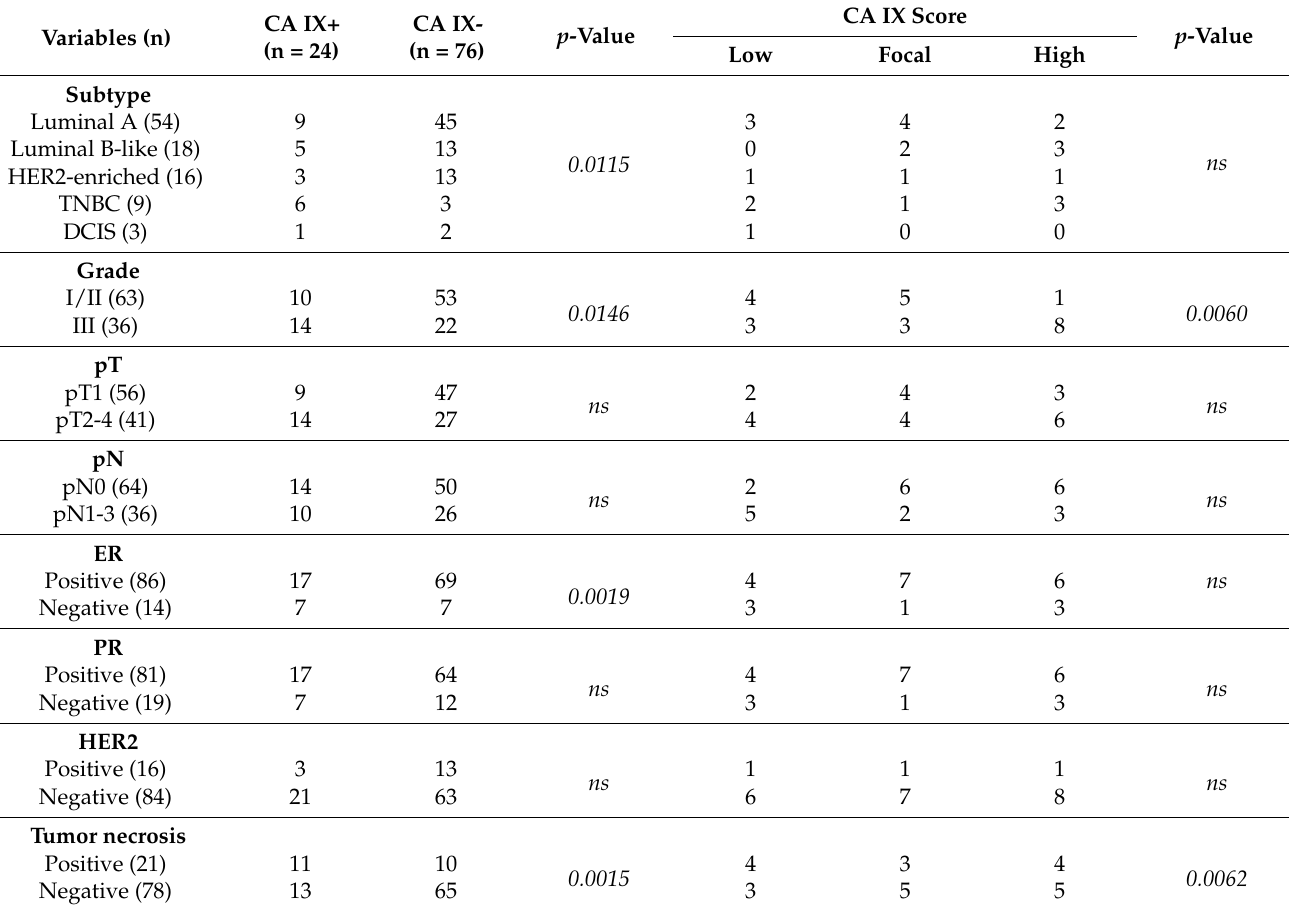
Table 2. Association of tumor tissue CA IX expression with clinicopathological